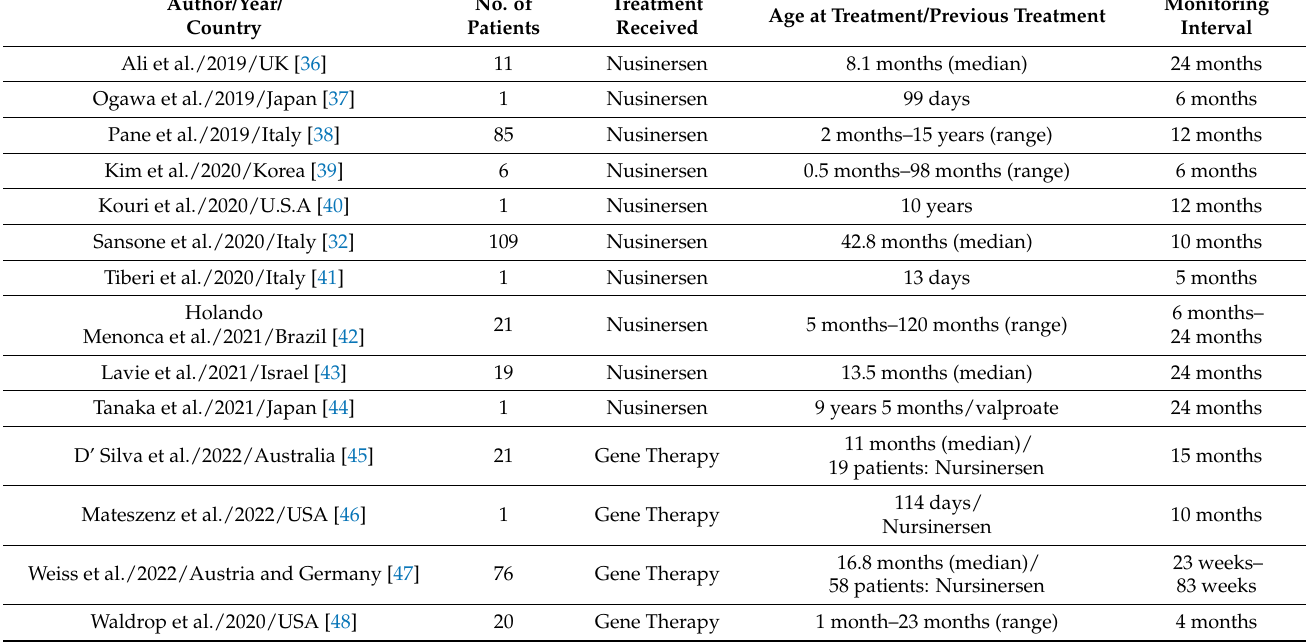
Table 2. Patients’ characteristics (with follow-up